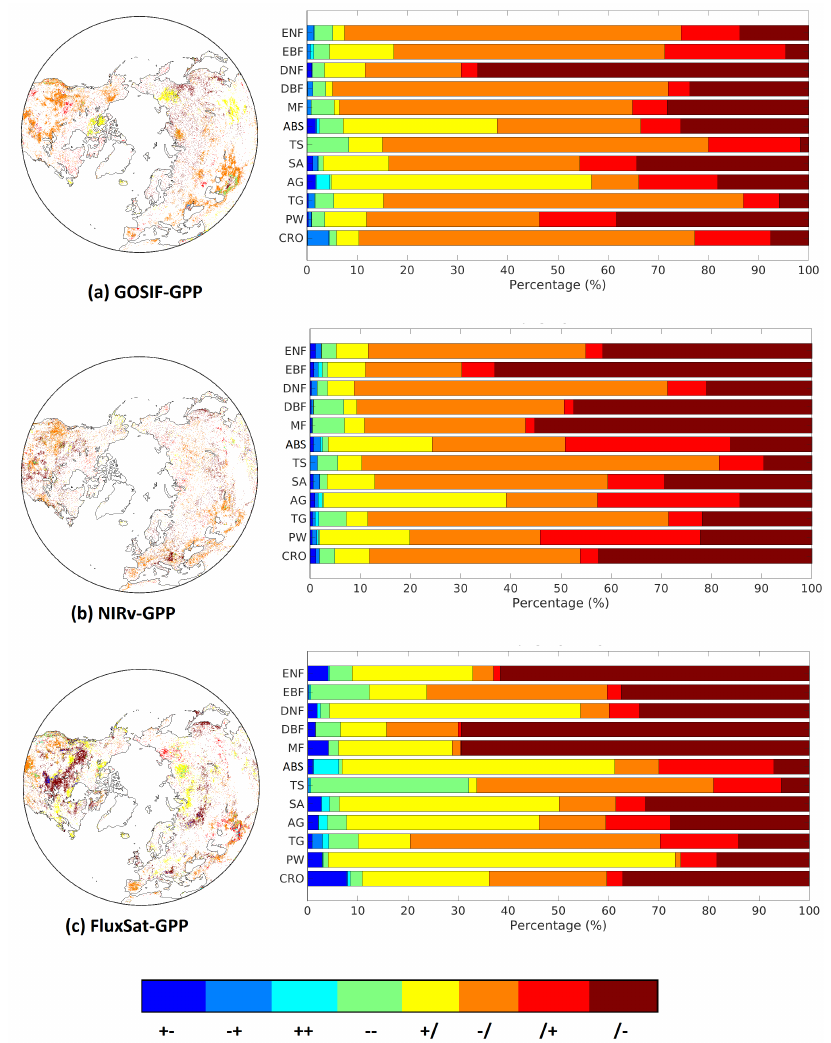
Figure 5. Transition patterns of legacy effects from T spring anomalies on GPP summer and GPP autumn for each biome, for: ( a ) GOSIF-GPP, ( b ) NIRv-GPP, and ( c ) FluxSat-GPP. The labels should be interpreted as follows: + − means there was a positive significant impact seen in summer and a negative in autumn, / − means there was an insignificant correlation seen in summer and a significant negative correlation in autumn). There were a total of eight different transition patterns excluding //, which means no significant legacy for both summer and